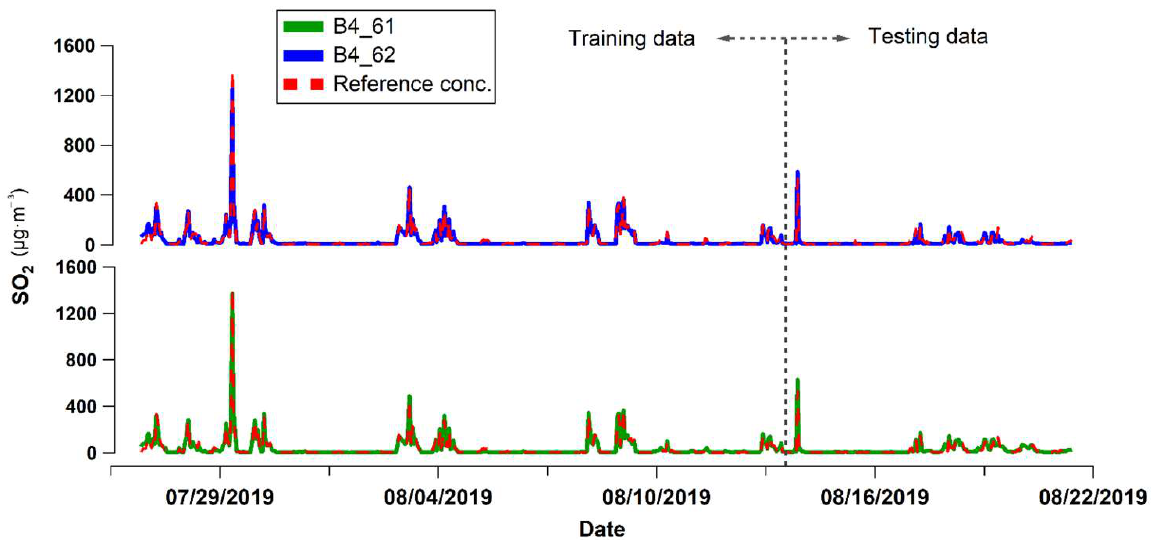
Figure 8. Time series of the 1-h average concentrations of SO 2 measured in the training campaign by the reference instrument and the sensors (calibrated response).